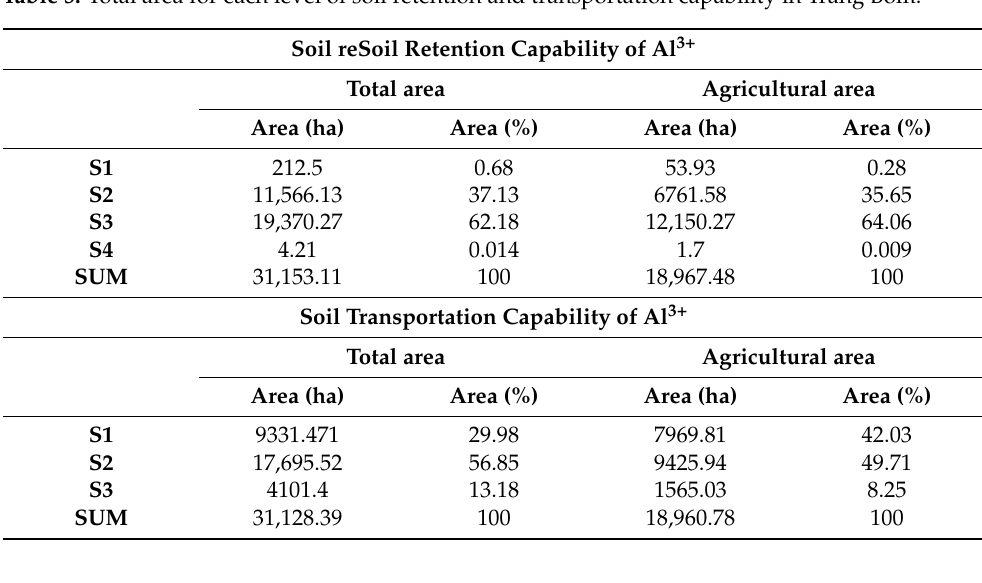
Figure 7. Maps show the levels of transportation capability of Al 3+ of each criterion.